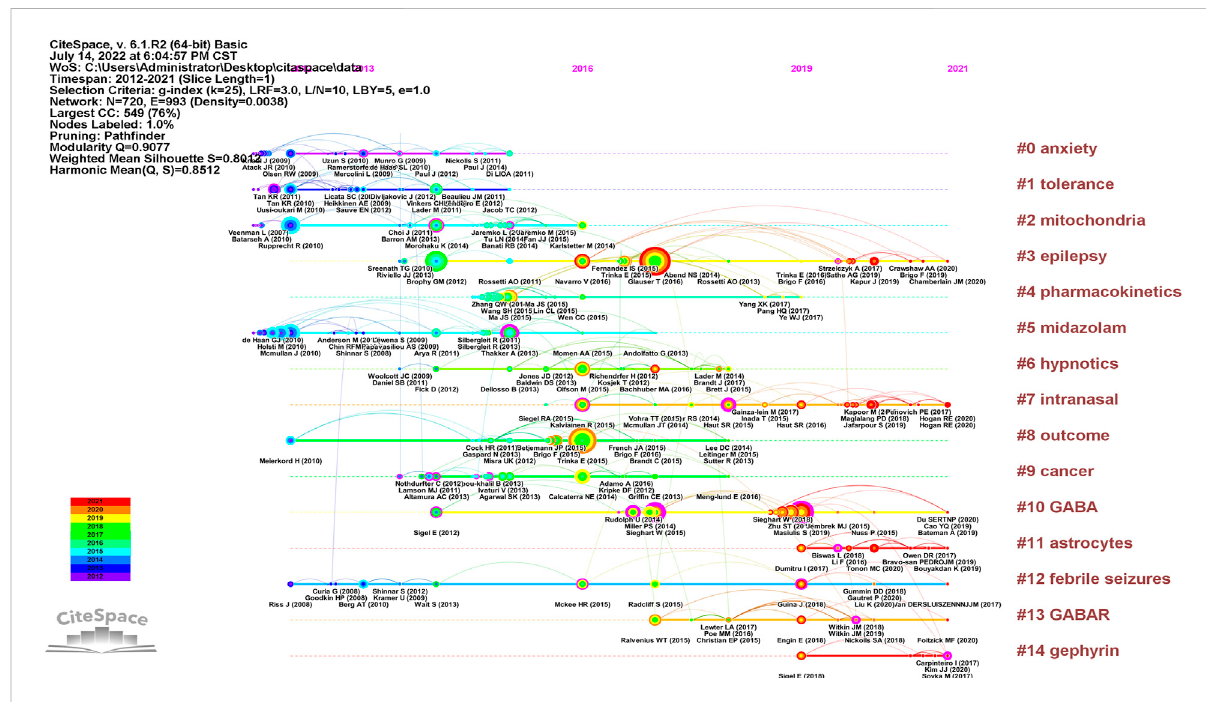
FIGURE 6 Timeline ofdiazepam researchreferences. Note:thesize ofthenodesispositivelycorrelatedwith thefrequencyofcitation,